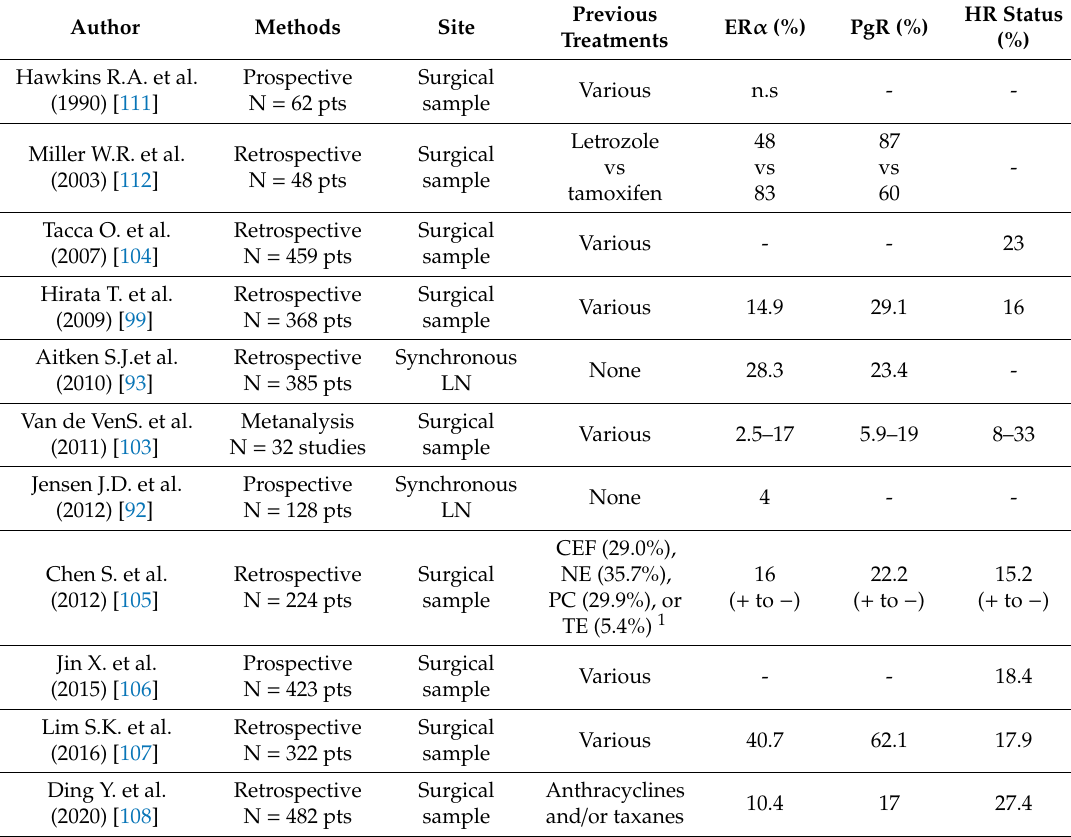
Table 1. Studies investigating the discordance rate between core needle biopsies (CNB)and synchronous LN (lymph nodes) / surgical